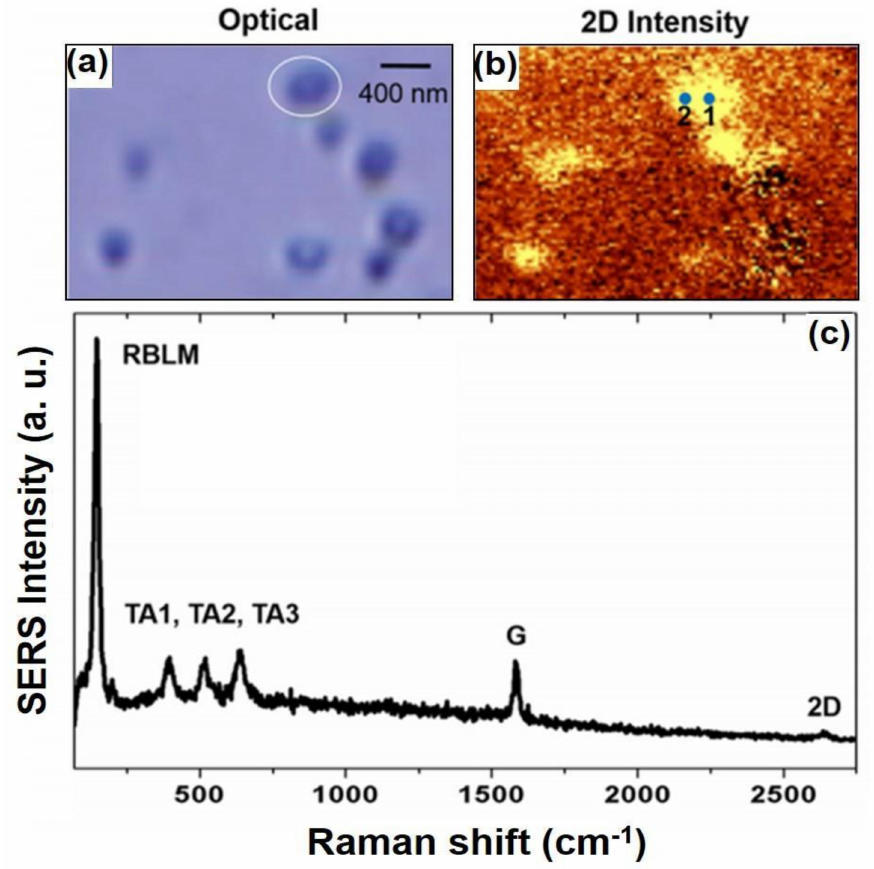
Figure 8. Bright-field and 2D intensity Raman images of CVD-MG at Au NP-Au film plasmonic junctions at the same region were shown in ( a , b ), respectively. The numbers in ( b ) indicated the location on the sample wherein the SERS spectra were recorded. ( c ) The representative SERS spectrum of an sGNR with immensely improved G band intensity was displayed. Reprinted with permission from ref.